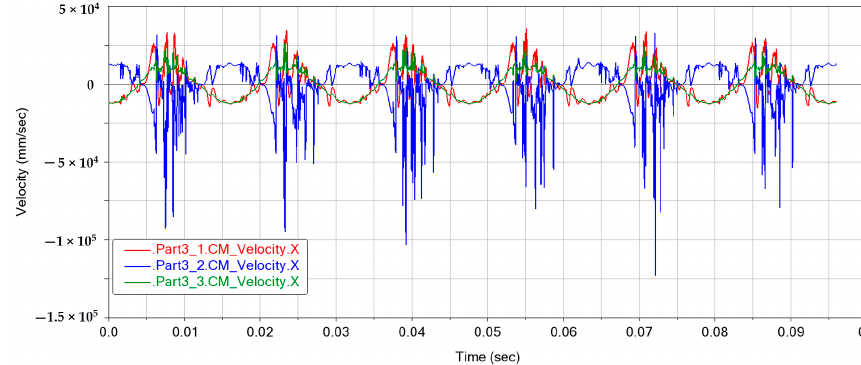
Figure 15. Engine connecting rod displacement curve.